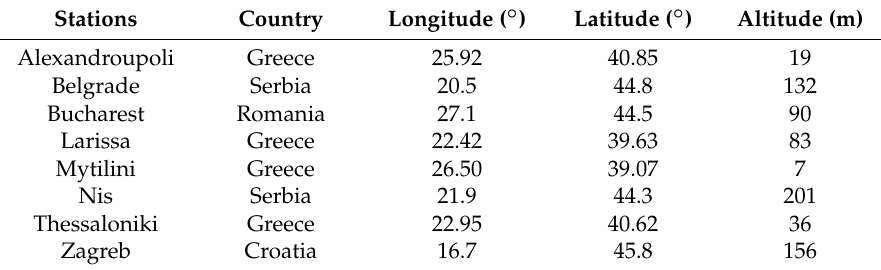
Table 1. The geographical characteristics of the stations used in the